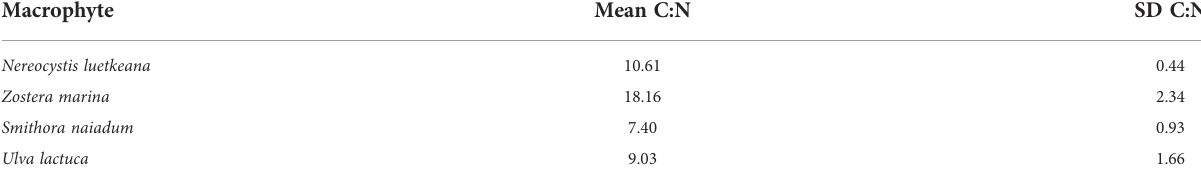
TABLE 1 Macrophyte carbon to nitrogen ratios (C:N) in the Z. marina meadow indicating their relative palatability. Macrophyte